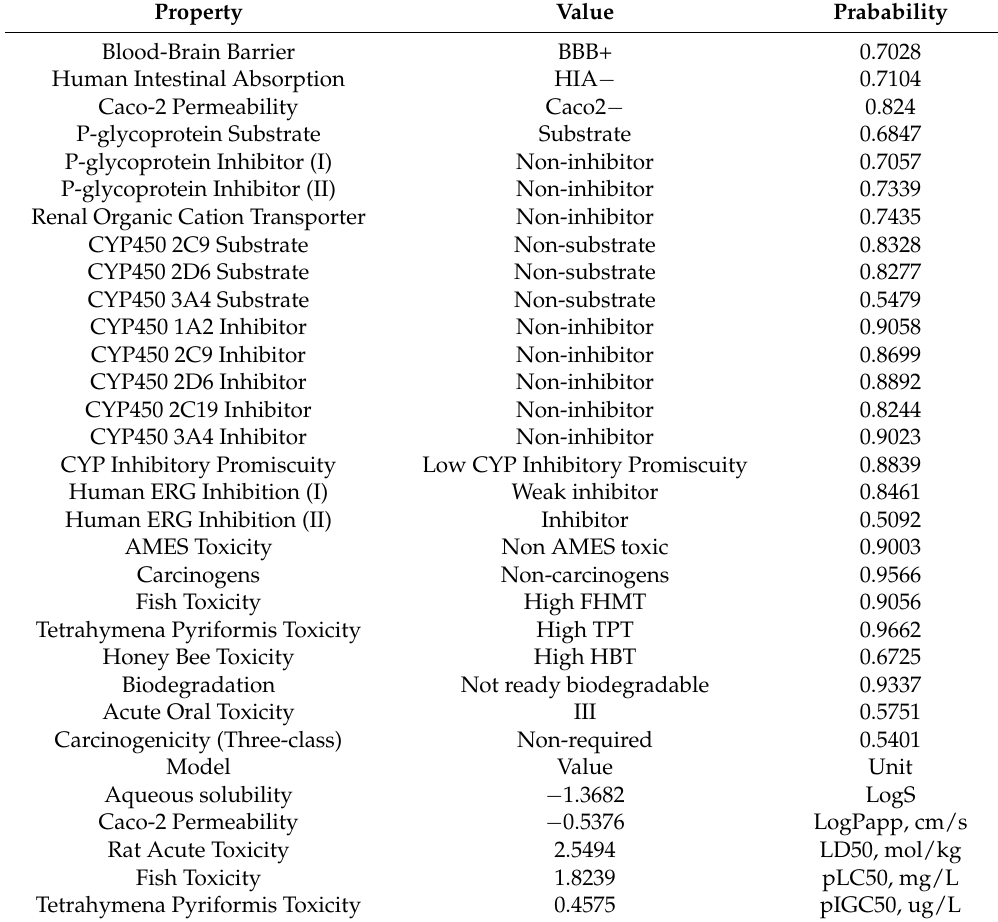
Table A1. ADMET properties of